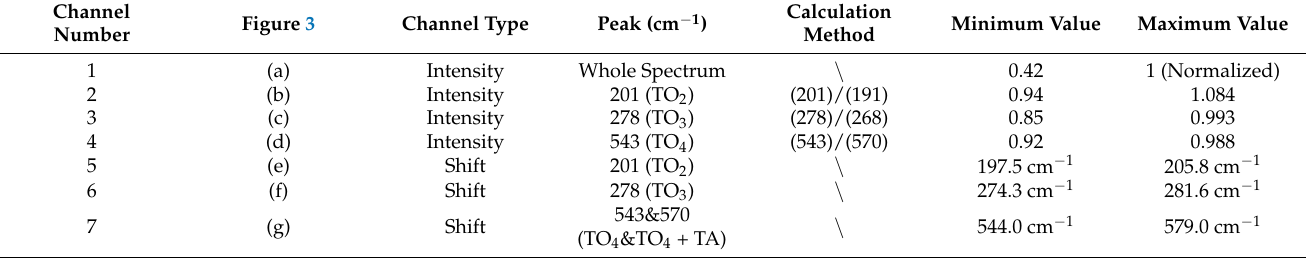
Table 1. The channel definitions used for the two-dimensional imaging of Raman spectra.